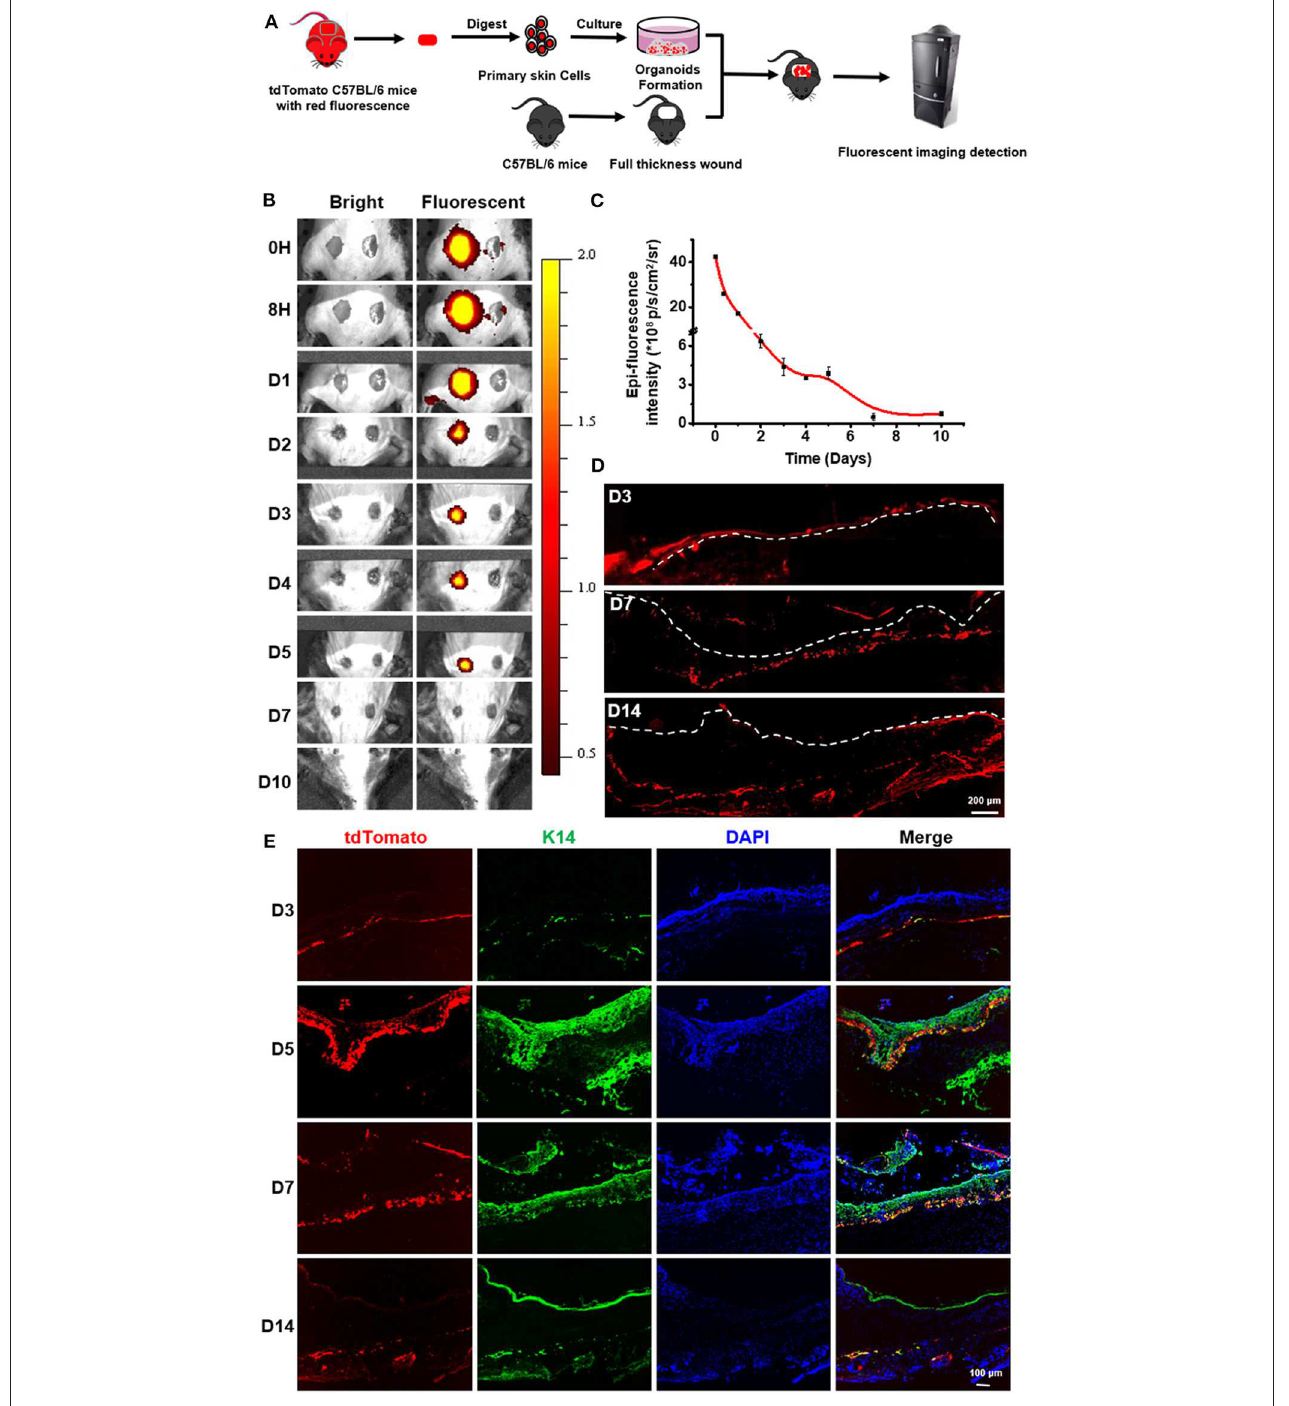
FIGURE 6 | In vivo imaging to monitor the sprayed td-Tomato mice-derived organoids on full thickness wounds. (A) Schematic to demonstrate the normal mice with wounds, used to monitor the effects of tdTomato-autologous cells isolated from syngeneic mice. (B) Overlay of the representative light and fluorescent images of skin wounds monitored from day 0 to 10 after spraying organoids (“sprayed” on the left) on the wound bed. The wounds without sprayed organoids (“non-sprayed” on the right) were used to normalized the fluorescence. (C) The estimates of the presence of the donor cells in the wound bed were calculated by subtracting the level of “non-sprayed” from that of “sprayed” areas, n = 3. (D) Fluorescent imaging on frozen sections to detect the existence of tdTomato-autologous cells after spraying of donor cells on wound sites. (E) Immunofluorescence staining of the wound tissue at days 3, 5, 7, and 14 to indicate the integration of sprayed donor cells onto the wound beds. The tissues were stained for